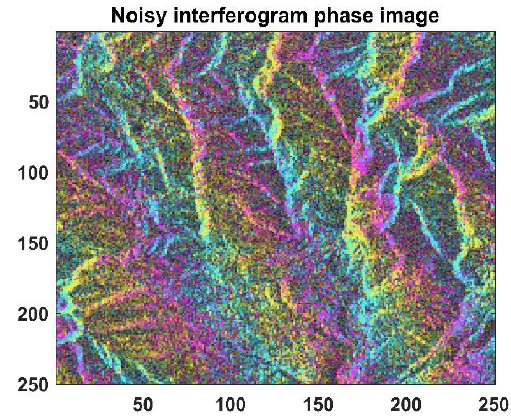
Figure 5. Interferogram with an area of size 250×250